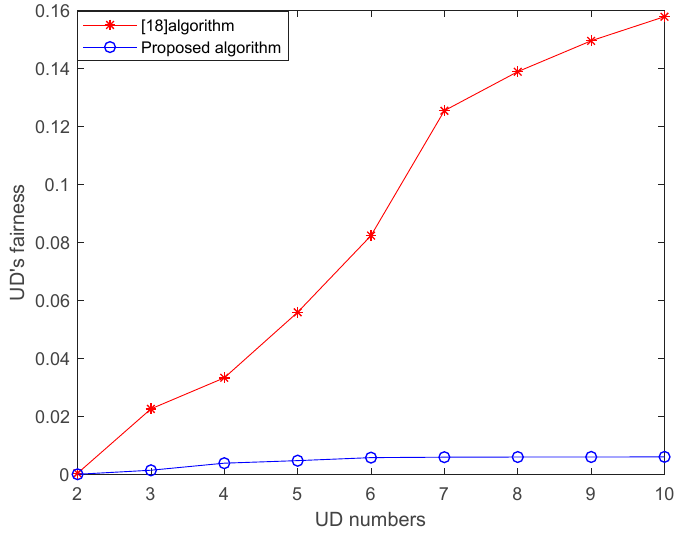
Figure 7. UD’s fairness with different UD numbers.